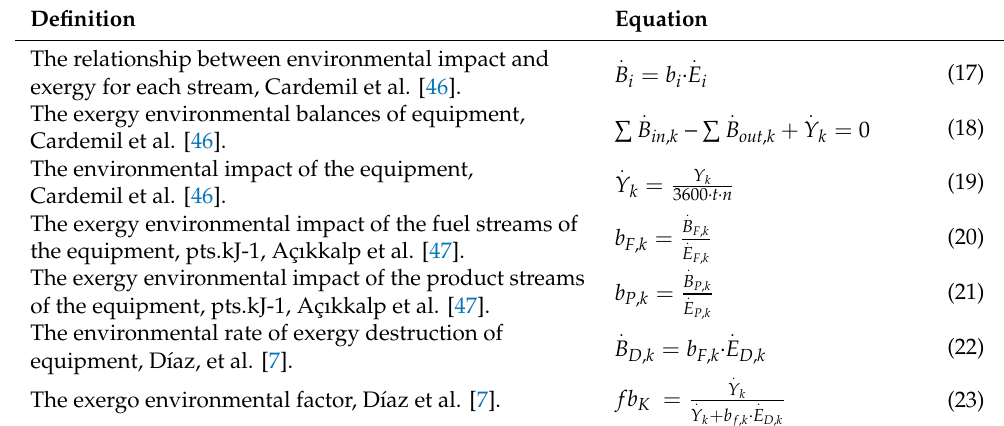
Table 3. Equations needed for the exergo-environmental